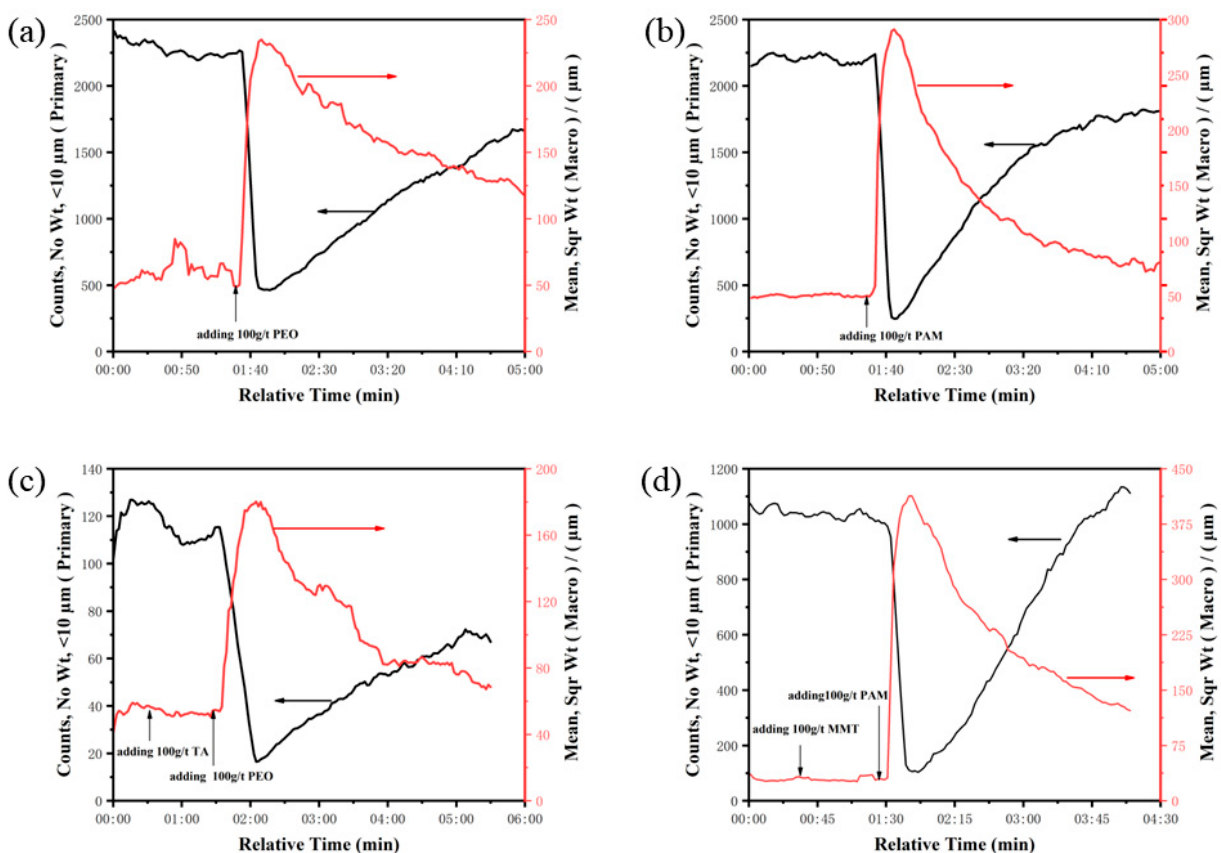
Figure 10. The trend of Mean Particle Size (square weighted, macro mode) and Counts of Fine Particles ( ≤ 10 µ m, no weighted, primary mode) as a function of stirring time: 400 rpm: ( a ) PEO; ( b ) PAM; ( c ) PEO-TA; ( d ) PAM-MMT.